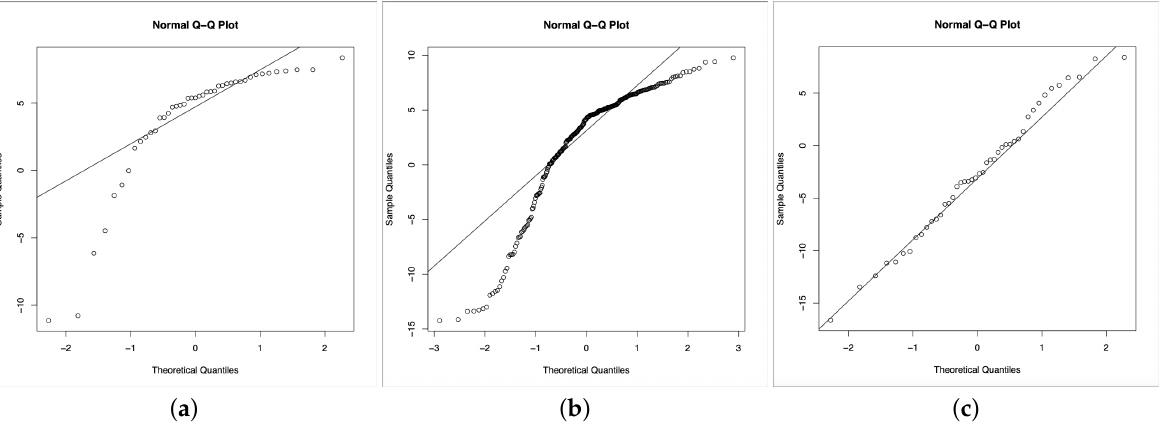
Figure 9. Q-Q plots for each patients’ class: ( a ) Healthy, ( b ) Chronic, and ( c ) Extrapyramidal.